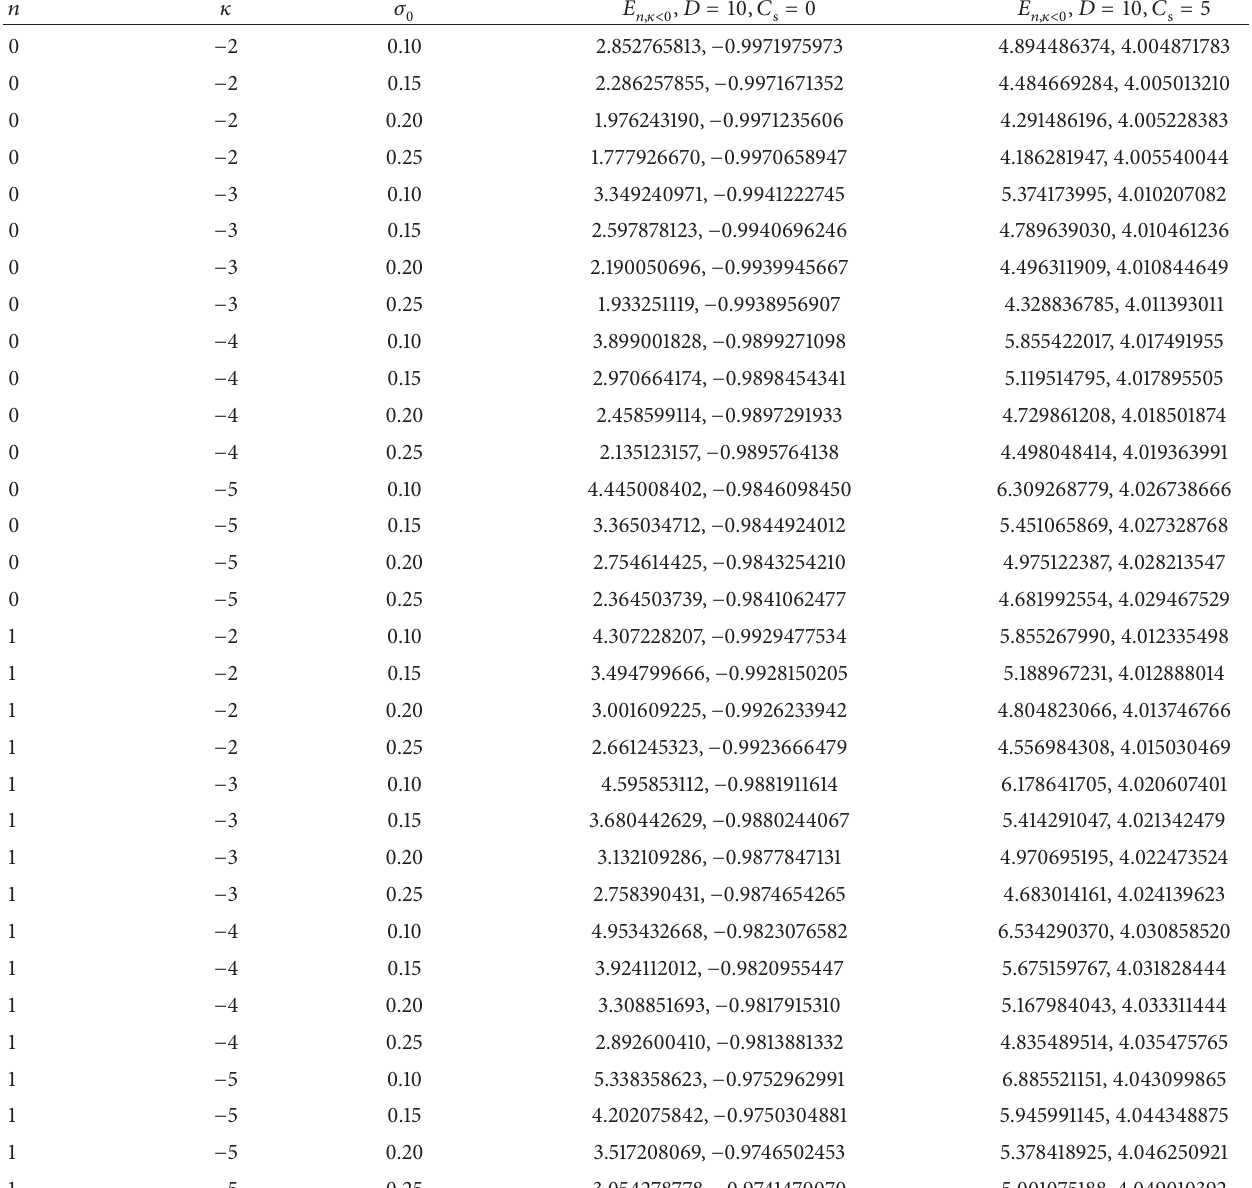
Table 2: Spin symmetry energies at the poles of 𝑠 -matrix (in units fm −1 ) for the hyperbolical potential as a function of positive potential parameter 𝜎 0 for different values 𝑛 and 𝜅 < 0 , 𝛼 = 0.1 and 𝐷 = 10 in atomic units (𝜇 = 7 = 1) , and 𝑐 𝑜 =